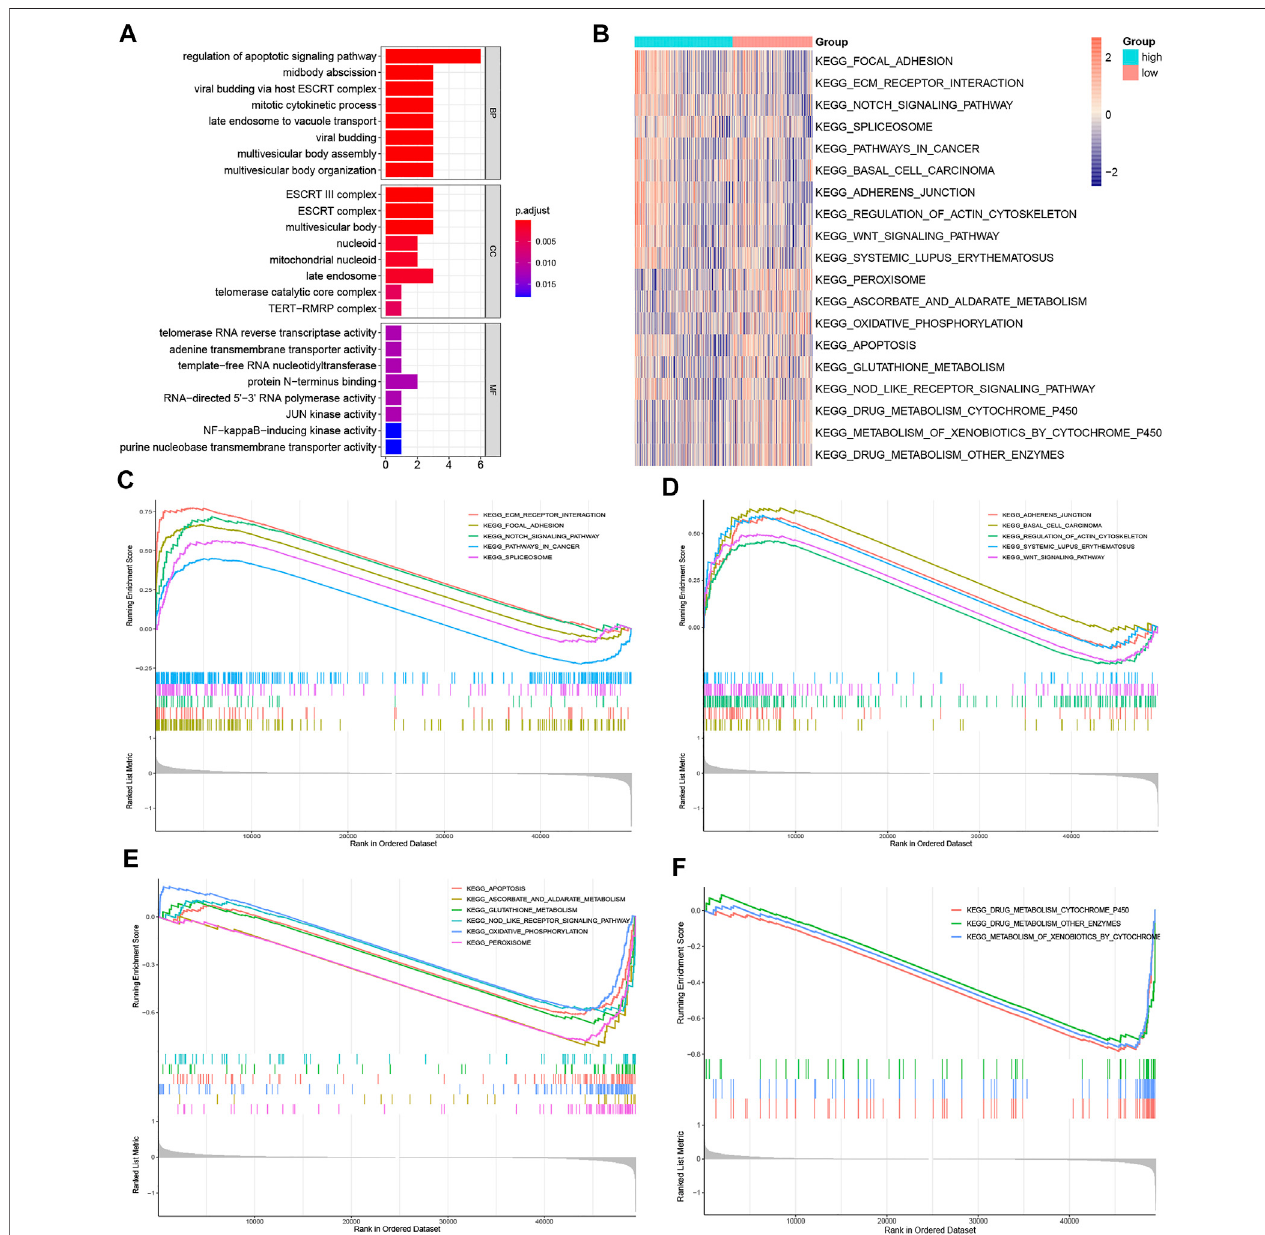
FIGURE 8 | Gene function enrichment analyses. (A). The signaling pathways enriched by necroptosis genes signatures through GO analysis; (B). The heatmap of ssGSEA of the KEGG gene sets; (C,D). KEGG enrichment analysis in the high-risk group; (E, F). KEGG enrichment analysis in the low-risk group.